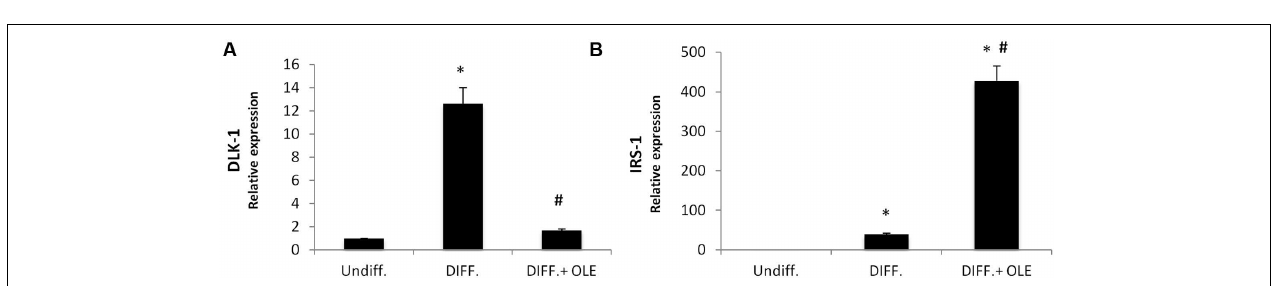
FIGURE 3 | Analysis of gene expression by Real time PCR of DLK-1 (A), and IRS-1 (B). All values are expressed as mean ± SEM of four experiments ( n = 4) in duplicate. ( ∗ P < 0.05 versus undifferentiated; # P < 0.05 versus